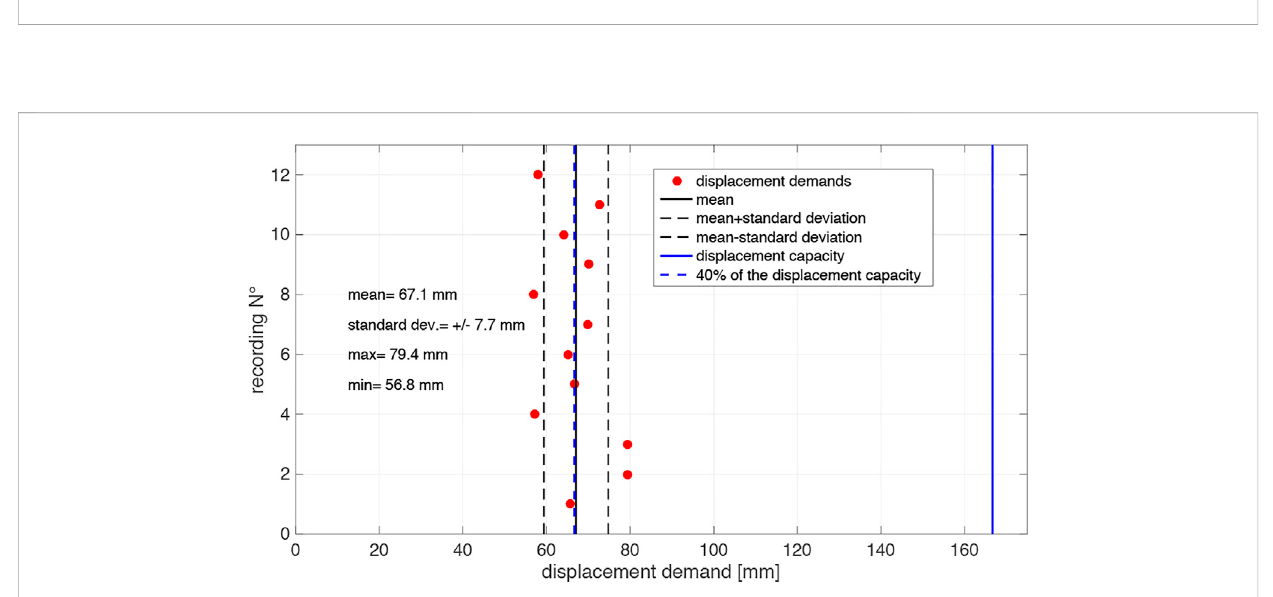
FIGURE 10 Non-lineardisplacementdemandsforthe12time-histories (TH).Theultimatedisplacementisconsideredtobereachedwhentheaverageexceeds 40% of 2/3 of the wall thickness (mean 12 TH > 0.4 · 2/3 · t w